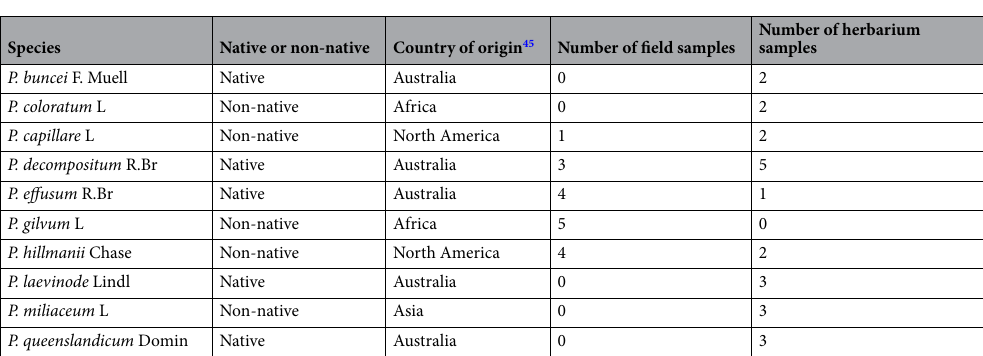
Table 1. Origin and number of Panicum species subjected to DNA barcoding analysis and derived from field site or herbarium collections. Each species was identified as native or non-native, with continent of origin